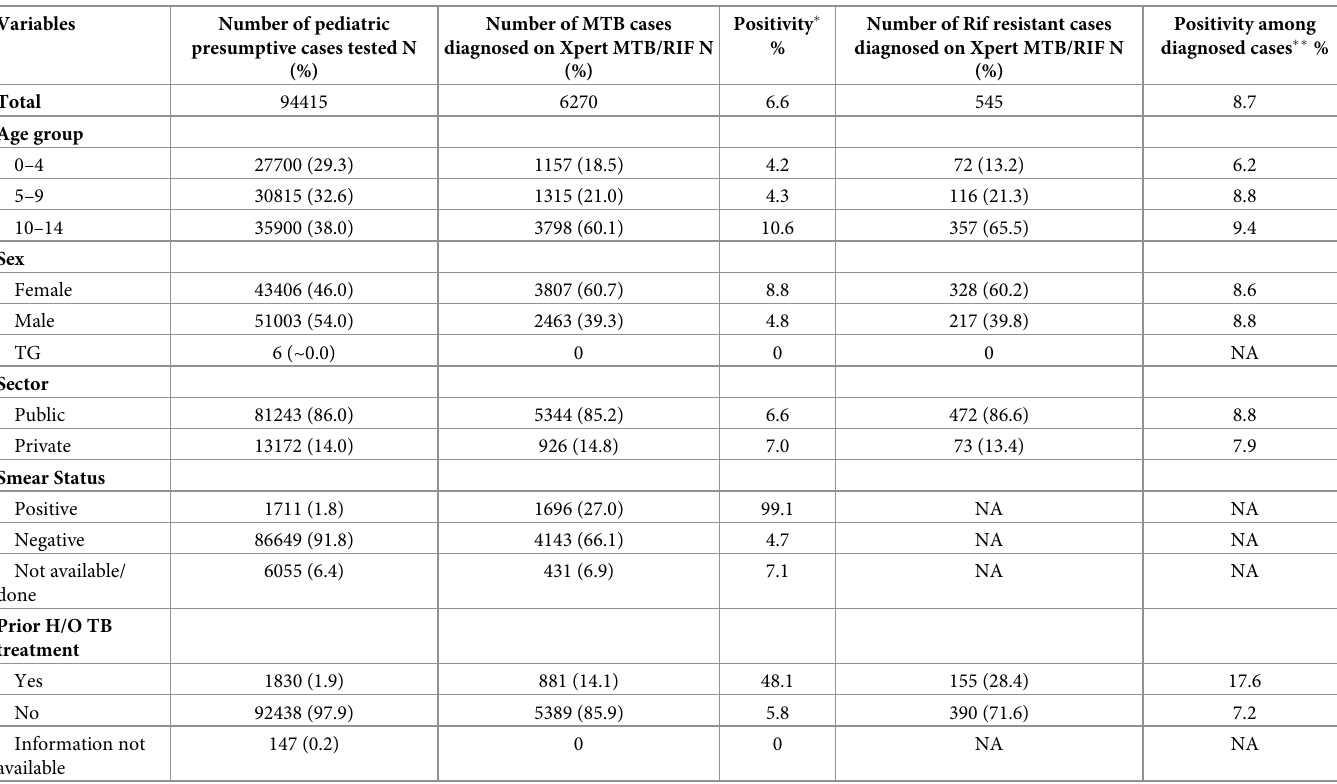
Table 1. Descriptive characteristics of presumptive paediatric TB cases enrolled under the project from ten cities in India, 2014–2018 (n = 94415).